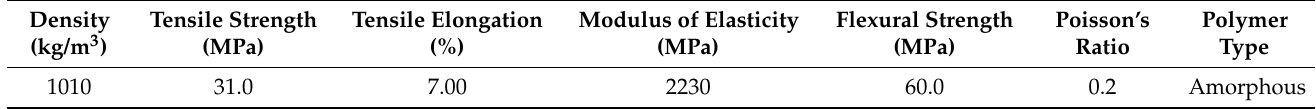
Table 1. Mechanical properties of